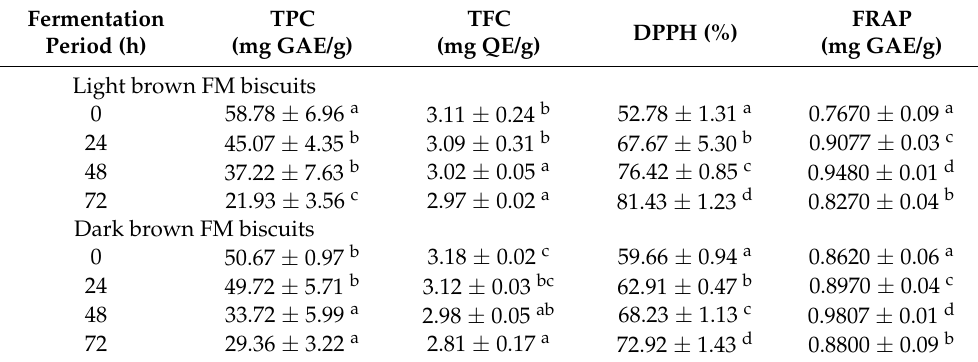
Table 3. Polyphenols and the antioxidant capacity of spontaneously fermented finger millet biscuits (dry